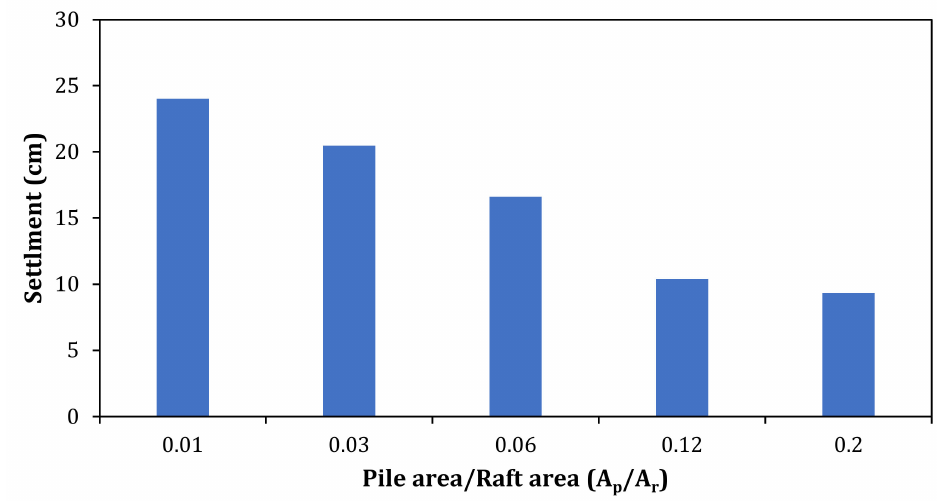
Figure 10. Pile area/raft area (A p /A r ) and effect on settlement.